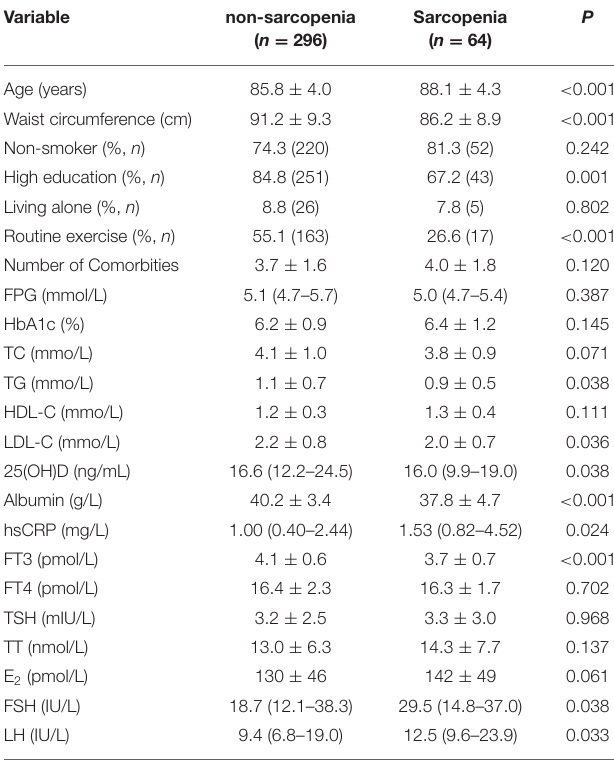
TABLE 1 | Characteristics of study population according to sarcopenia status.